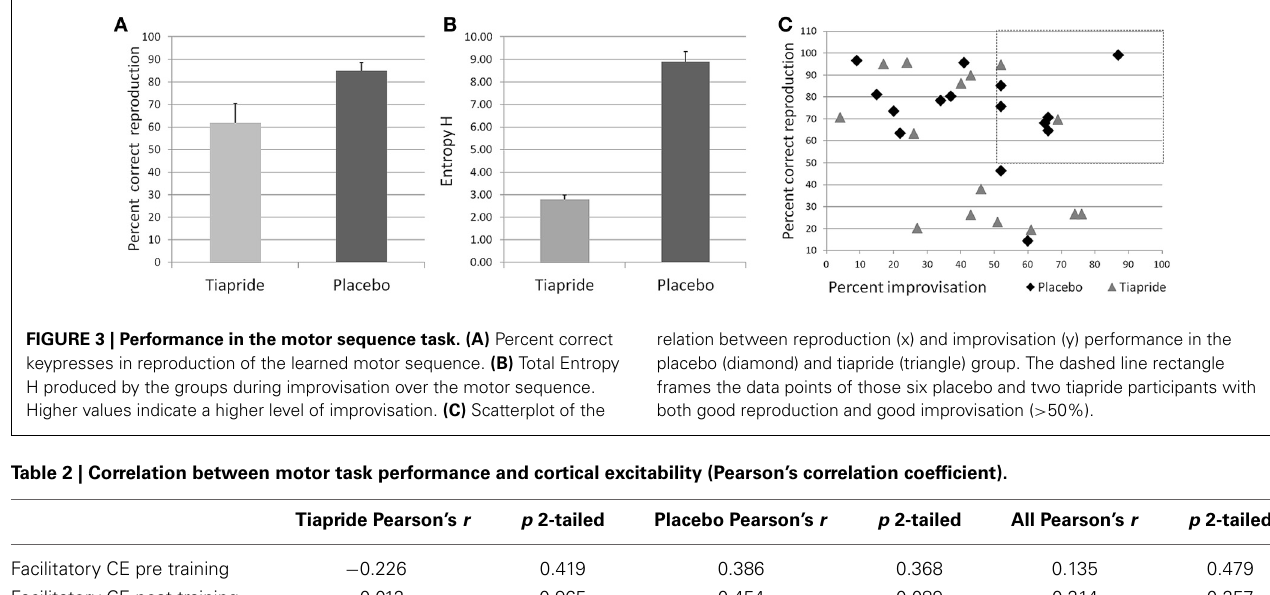
Table 2 | Correlation between motor task performance and cortical excitability (Pearson’s correlation coefficient). Tiapride Pearson’s r p